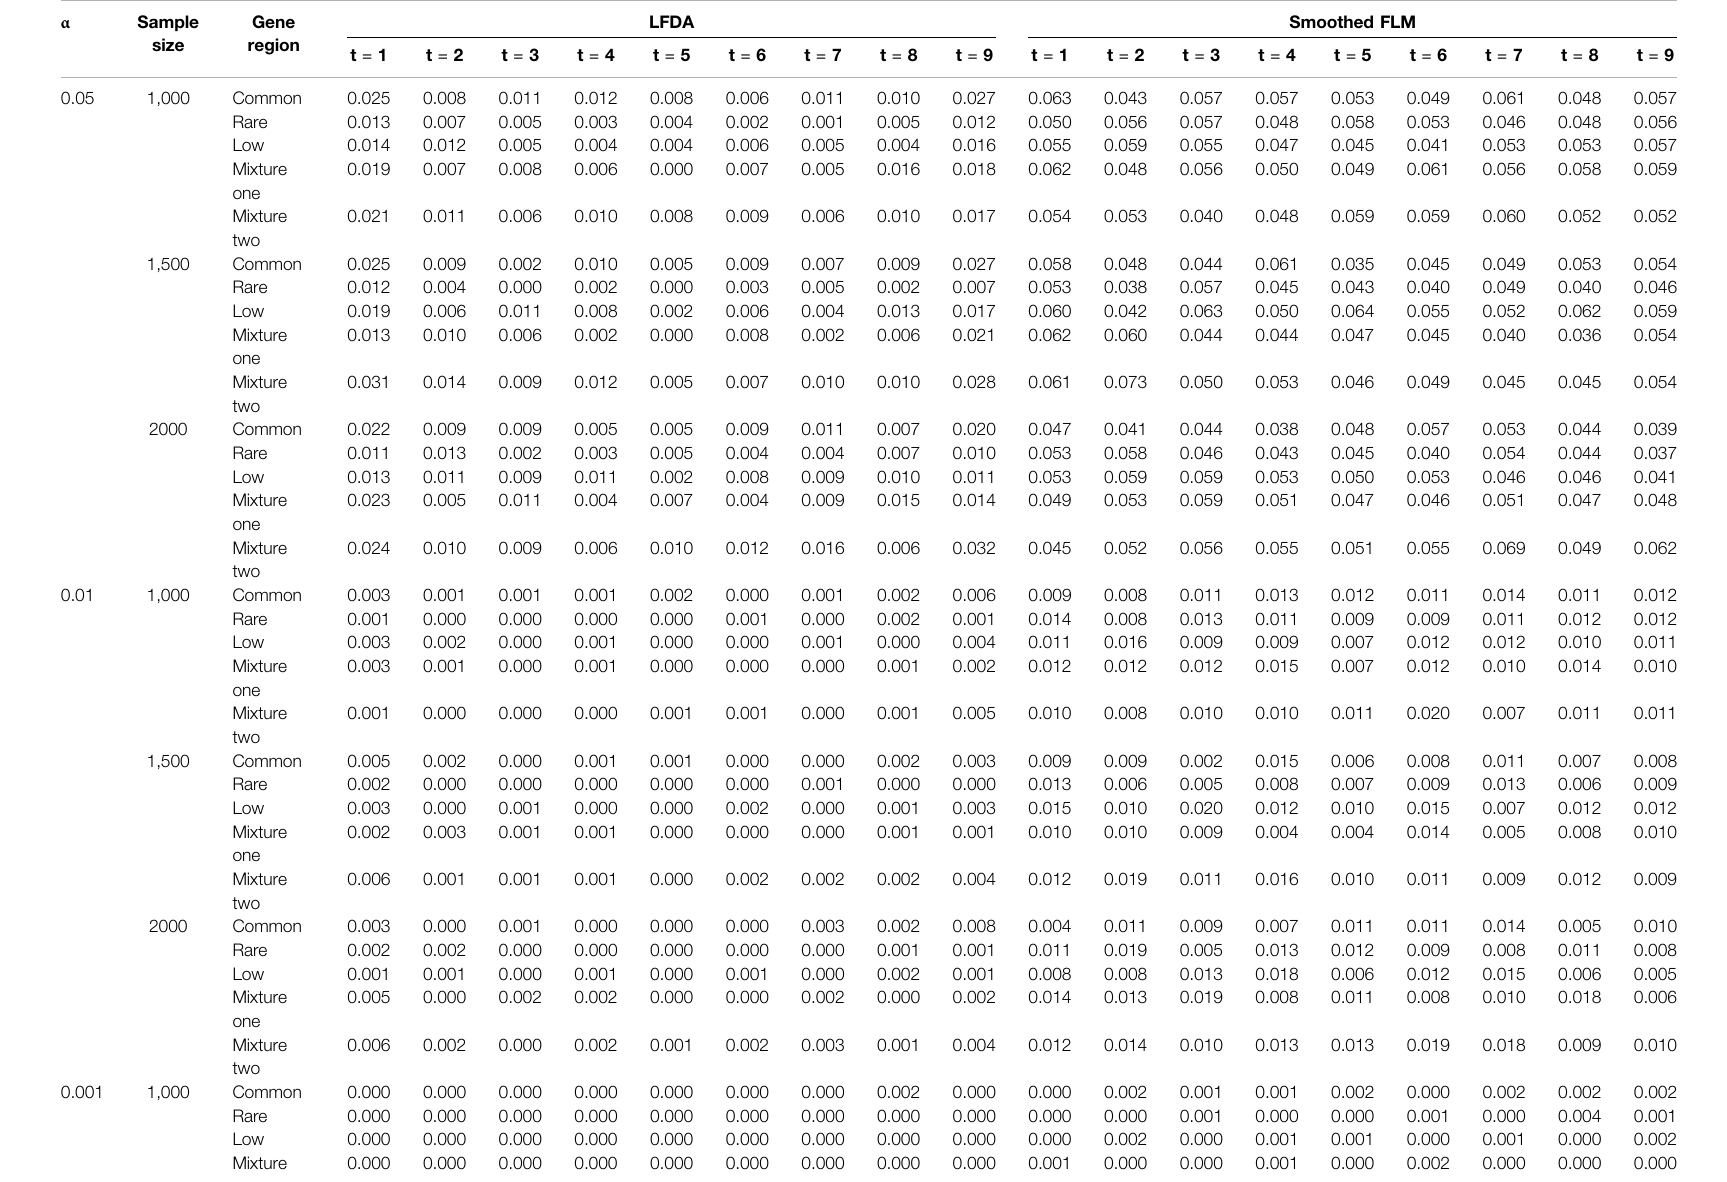
TABLE 1 | Type I error rates of the LFDA and Smoothed FLM based on 1,000 simulated replicates for linkage equilibrium